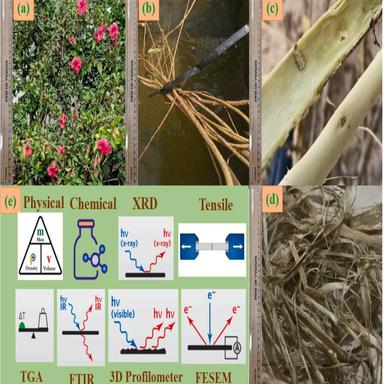
(a) Hibiscus Rosa-sinensis plant; (b) microbial degradation process; (c) extraction of stalk from stem; and (d) extracted HRFs; (e) characterization techniques.